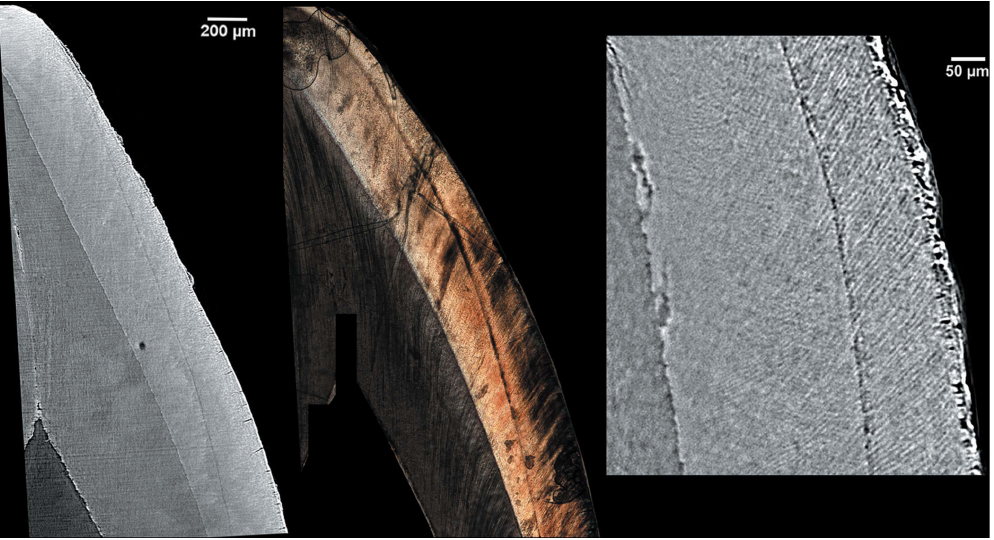
Figure 4 Velia 96 lower deciduous central incisor. Left: vestibular-lingual reformatted image from SR m CT, isotropic voxel size = 2.0 m m, slice thickness = 20 m m. Center: optical microscopy image of a vestibular-lingual histological section of the same tooth taken with 10 (cid:4) objective magnification (0.52 m m pixel size). Right: vestibular-lingual image from SR m CT, isotropic voxel size = 0.9 m